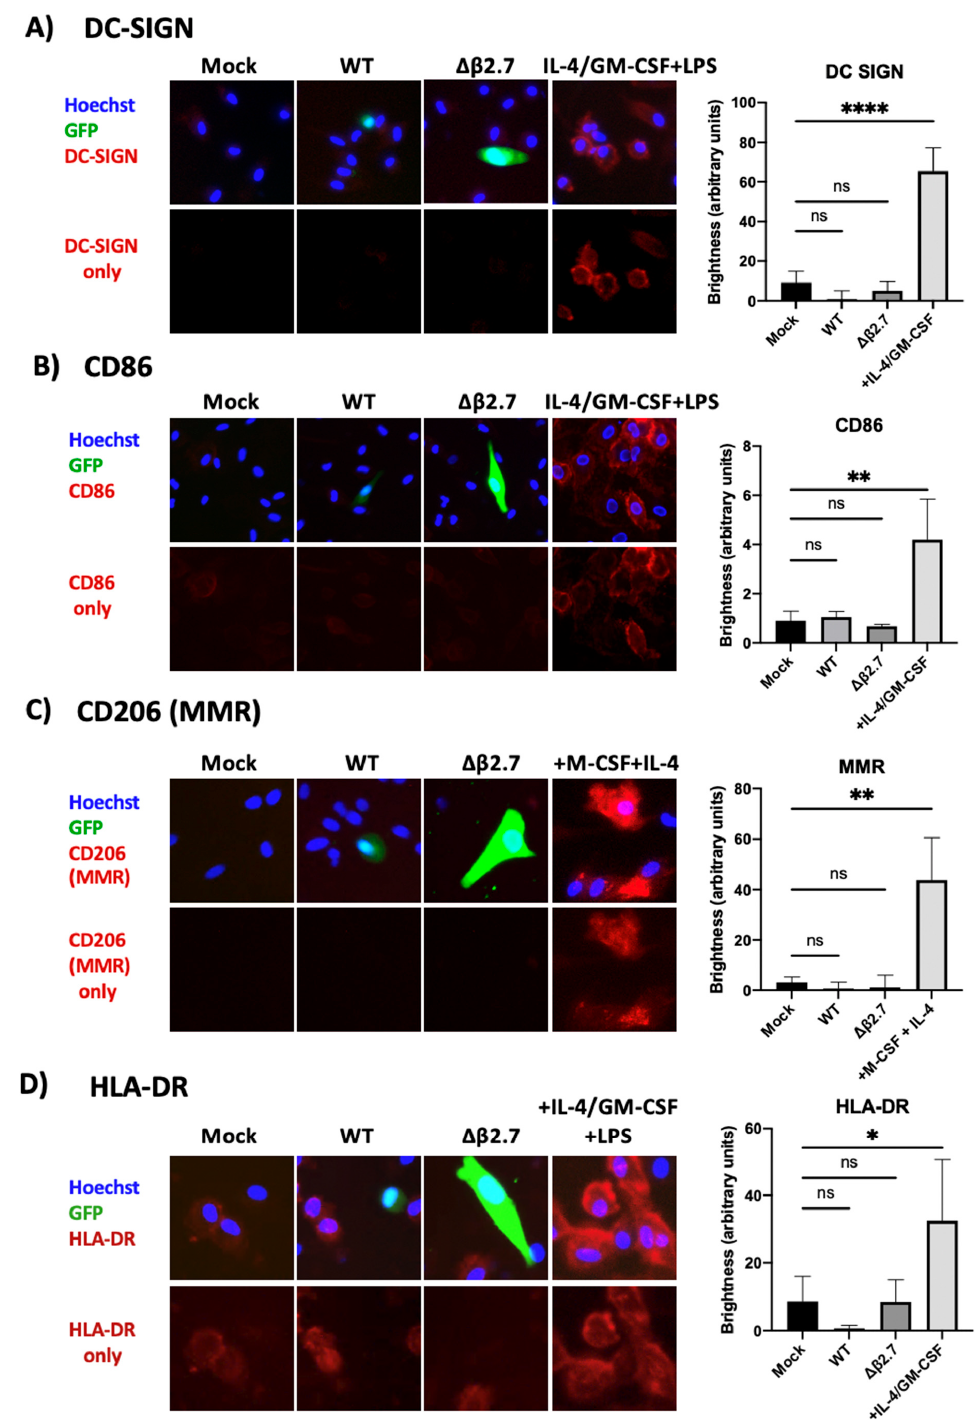
Figure 10. Δβ 2.7 virus infected cells show no evidence of differentiation. CD14+ monocytes were mock infected or infected with WT TB40E SV40-GFP (WT) or Δβ 2.7 TB40E SV40-GFP ( Δβ 2.7) at an MOI of 5 and fixed at 7 d.p.i. Additional primary monocytes were also differentiated to: ( A , B , D ) den- dritic cells with IL-4, GM-CSF and LPS, or ( C ) M2 macrophages with M-CSF and IL-4. Fixed cells were stained for ( A ) DC-SIGN, ( B ) CD86, ( C ) CD206 (MMR) and ( D ) HLA-DR and representative photos were taken on a fluorescence microscope using a 20 × lens. Brightness was quantified using densitometry analysis on ImageJ software. Significant difference was determined using a one-way ANOVA with Dunnett’s multiple comparison testing. ns = not significant, * = p < 0.05, ** = p < 0.01, **** = p <